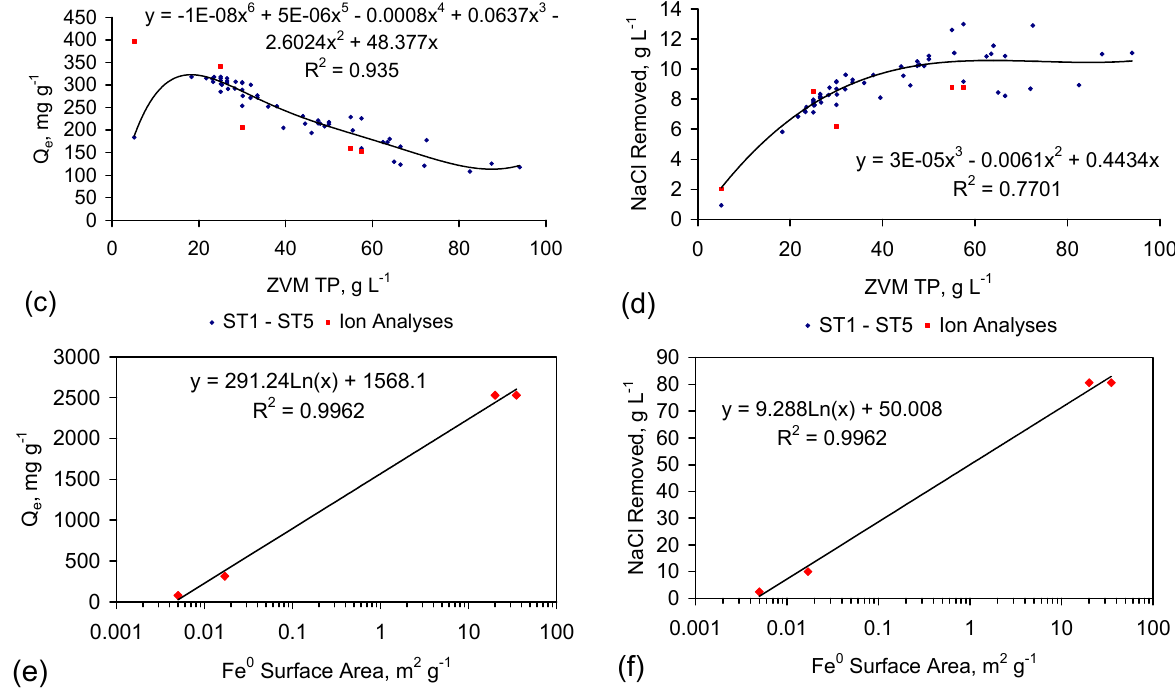
Figure 9. ( a ) Q e (without adjustment for water consumption) vs. ZVM TP concentration; ( b ) Measured relationship (Table 1) between Q e (without adjustment for water consumption) vs. Q e (with adjustment for water consumption); ( c ) Q e (with adjustment for water consumption) vs. ZVM TP concentration; ( d ) Total NaCl removed, g·L − 1 vs. ZVM TP concentration; ( e ) Q e (with adjustment for water consumption) vs. Fe 0 BET surface area, based on a ZVM TP